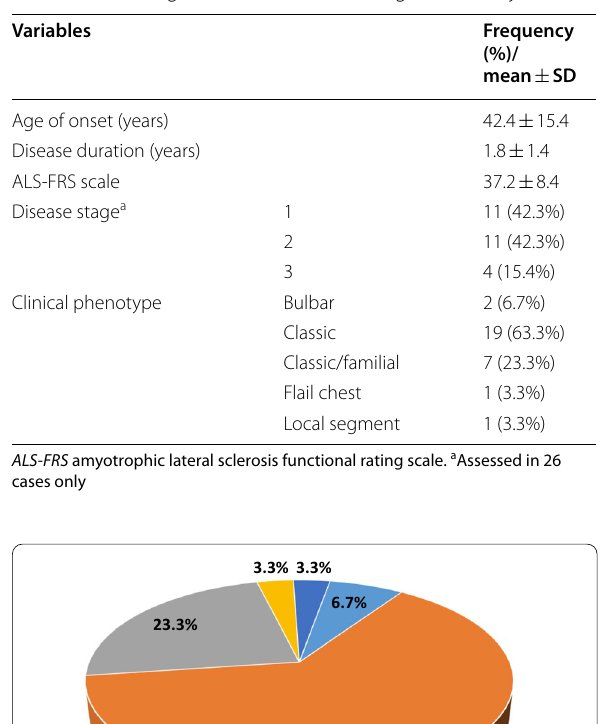
Table 3 Basic clinical results among 30 ALS subjects